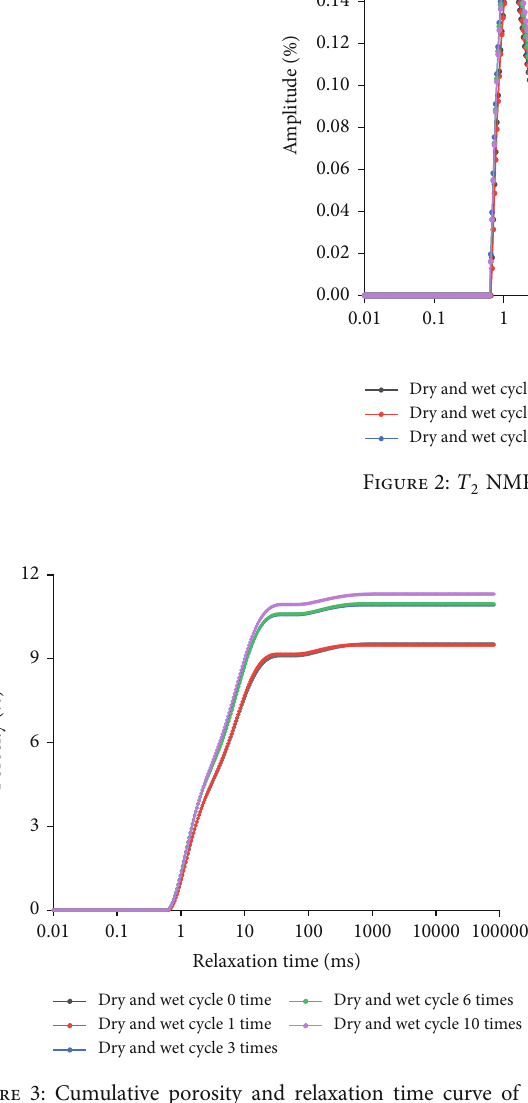
Figure 3: Cumulative porosity and relaxation time curve of red sandstone.